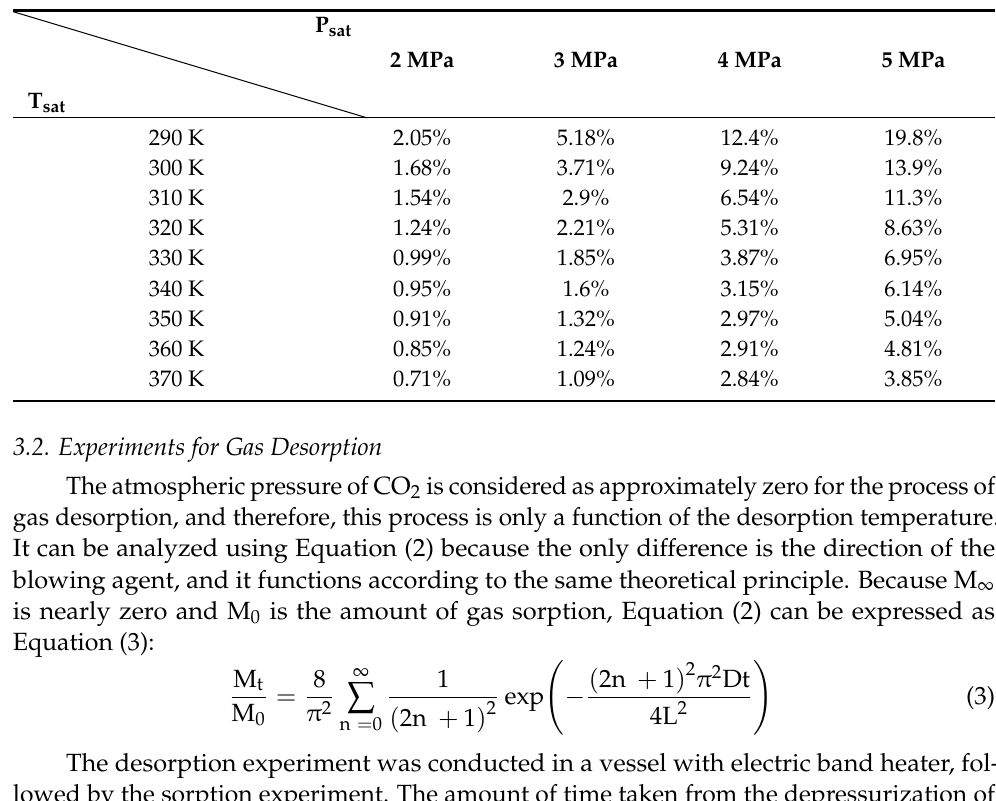
Table 2. Solubility at various saturation temperatures and pressures.